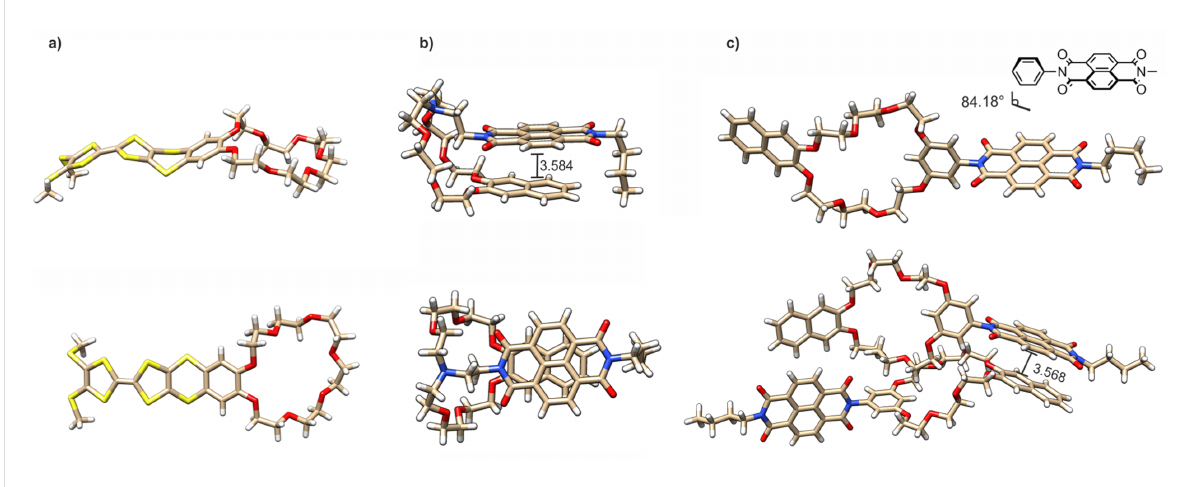
Figure 2: Solid-state structures of a) exTTFC7 (CH 3 CN molecule omitted for clarity), b) NDIC7 (CH 3 CN molecule omitted for clarity) and c) NDIC8 .